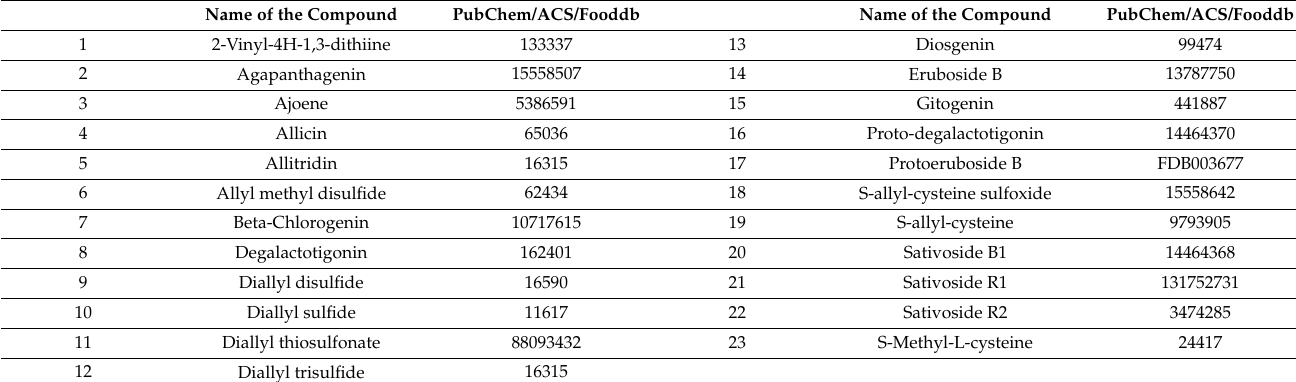
(Table 5), like zero order, first order, Higuchi, Korsmeyer-Peppas models to establish the kinetics of drug release [46]. Table 5. List of bioactive compounds present in Allium sativa